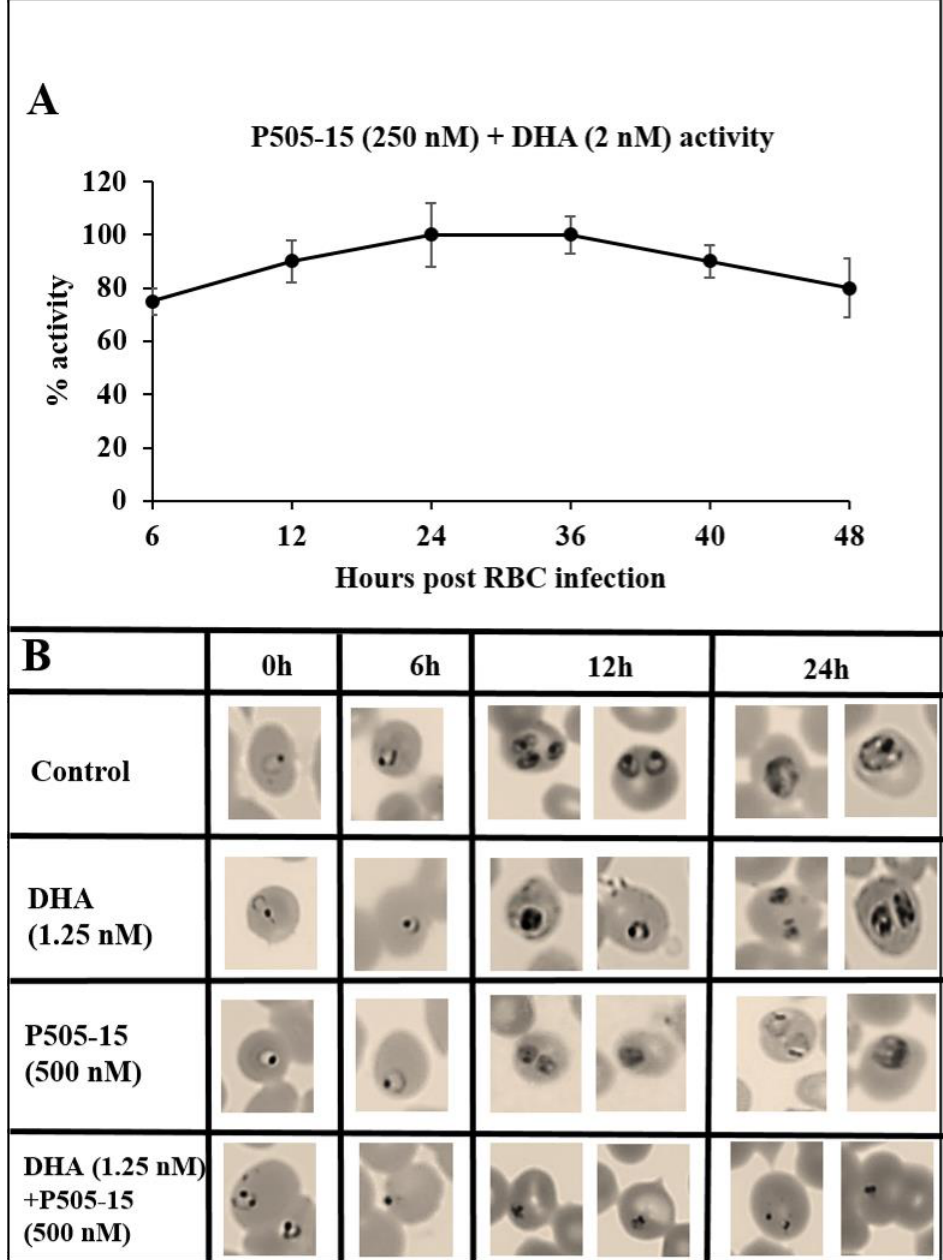
Figure 8. ( A ) Stage dependency of the efficacy (6, 12, 24, 36, 40, and 48 h) expressed as relative activity at one fixed dosage of DHA + P505-15 (2 nM + 250 nM). Relative activity of DHA + P505-15 (2 nM + 250 nM) added at 6, 12, 24, 36, 40, and 48 h of incubation. Values are expressed as percentage of DHA + P505-15 activity (treatment time at 24 h post infection) measured as % activity. Data are the average of five experiments ± SD. ( B ) Morphological changes in P. falciparum induced by Syk inhibitor (P505-15) in combination with a fixed concentration (1.25 nM) of dihydroartemisinin after 6, 12, and 24 h of treatment. Representative images of selected damaged parasites at 6, 12, and 24 h of treatment in control and drug-treated cultures selected from Diff-Quik ® fix-stained thin blood films. The micrographs were obtained using a Leica DM IRB microscope equipped with a 100× oil planar apochromatic objective with 1.32 numeric aperture and a DFC420C camera and DFC software version 3.3.1 (Leica Microsystems, Wetzlar, Germany). The scale bar in the figure is 7.5 µm.